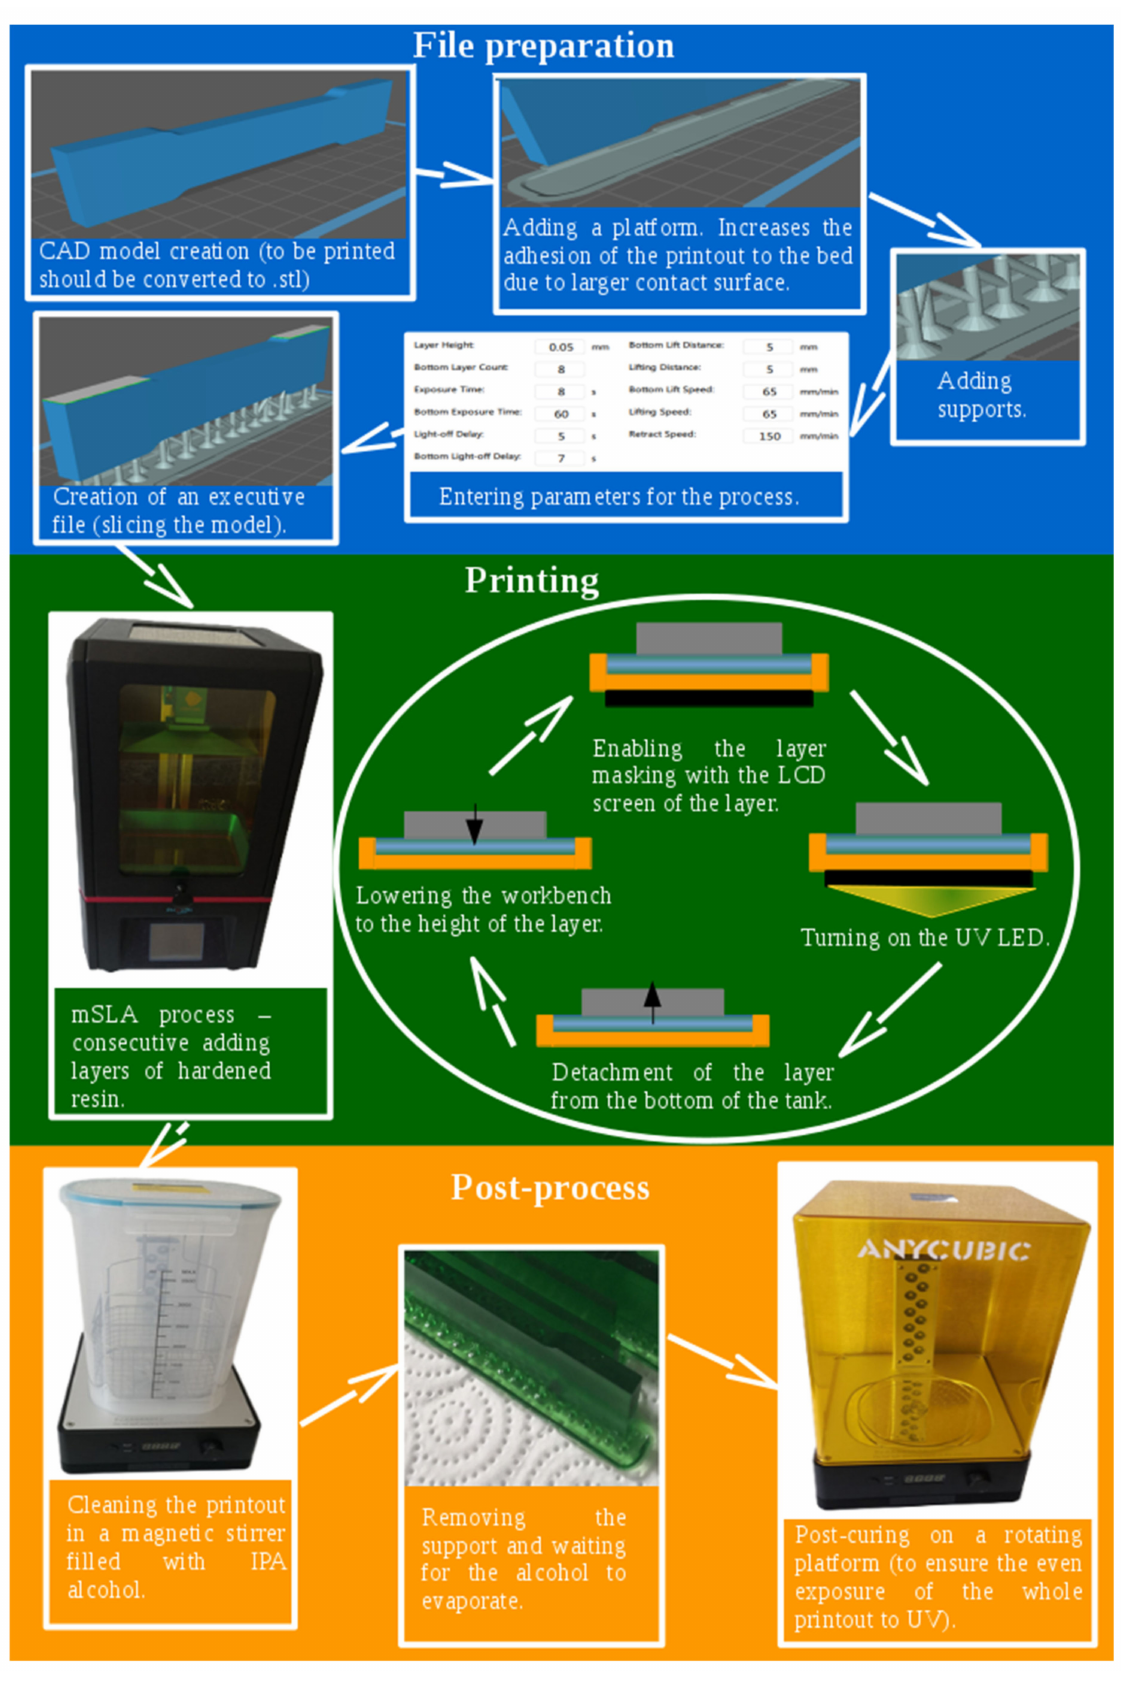
Figure 2. Graphical scheme of performed mSLA